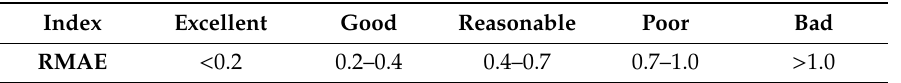
Table 1. RMAE (relative mean absolute error) classification rates [29].